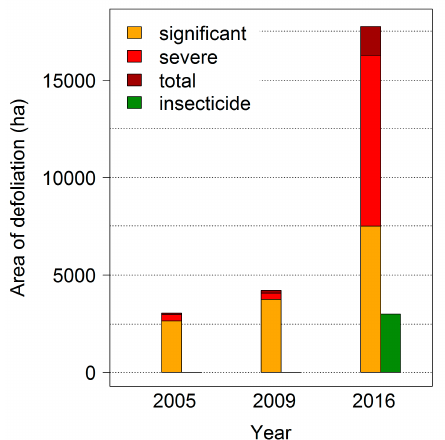
Figure 5. Area of defoliation of pine stands in the study area during the last three mass progradations of D. pini . The stacked bars represent the intensities of defoliation (significant: 31–50%; severe: 51–90%; total: >90%). The green bars indicate the area of insecticide application.